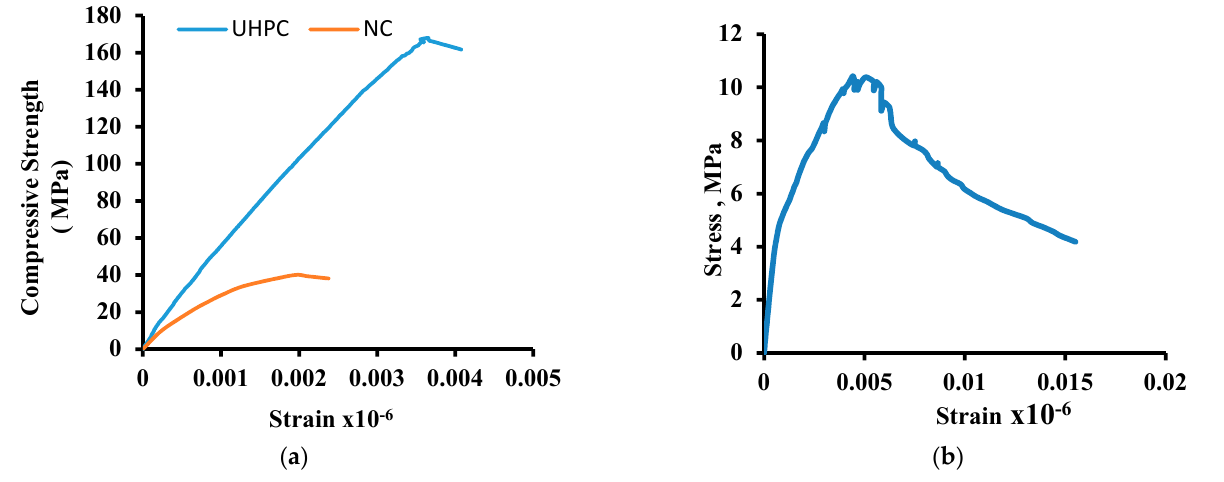
Figure 4. Stress–strain diagram: ( a ) UHPC and NC under compression, ( b ) UHPC under direct ten- sion.